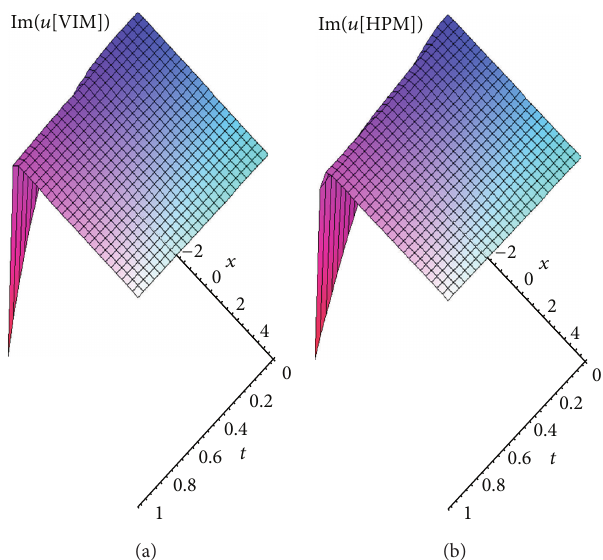
Figure5:Theimaginarypartoftheapproximatesolutionwhichobtainedbythevariationalitearationmethod(38)shownin(a)incomparison with the of the approximate solutions which obtained by homotopy perturbation method (32) shown in (b) when 𝛼 = 0.99 , 𝛽 = 0.99 , −5 < 𝑥 < 5 , and 0 < 𝑡 < 1